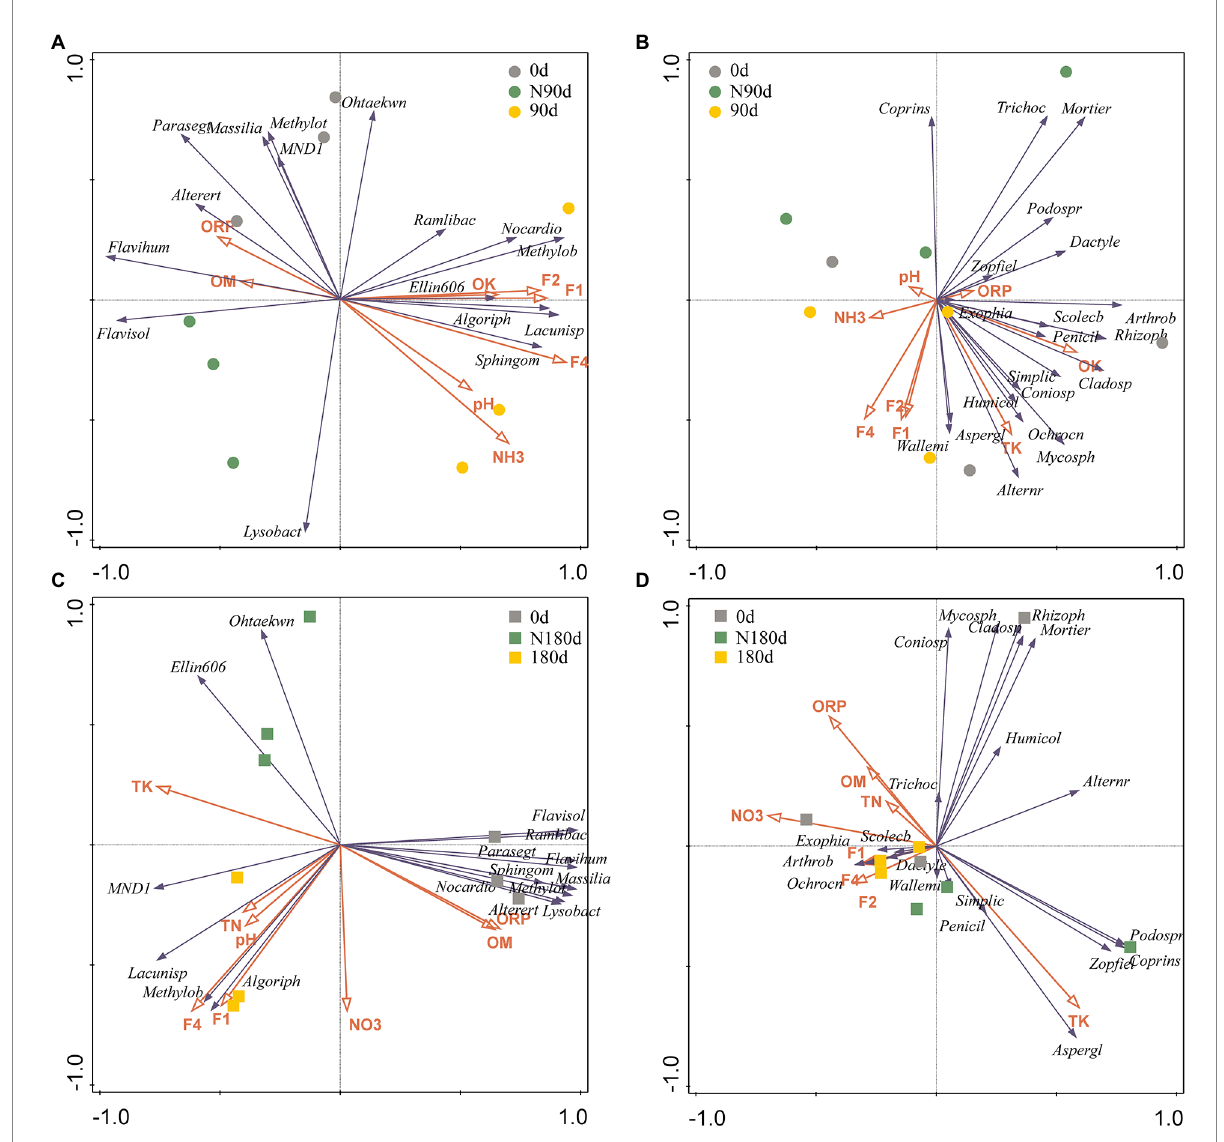
FIGURE 3 The ordination plot from redundancy analysis (RDA) showing the relationship between the microbial community structures and environmental factors. (A) Bacterial genera with more than 2% abundance of 90 days; (B) the fungal genera with more than 2% abundance of 90 days; (C) the bacterial genera with more than 2% abundance of 180 days; (D) the fungal genera with more than 2% abundance of 180 days. Each point represents the individual microbial community in soils. Arrow direction indicates the correlation among soil properties; arrow length indicates the strength of the correlation. ORP, oxidation–reduction potential; TN, total N; NH 3 , ammonium nitrogen; NO 3 , Nitrate nitrogen; TK, total K; OK, available K; OM, organic